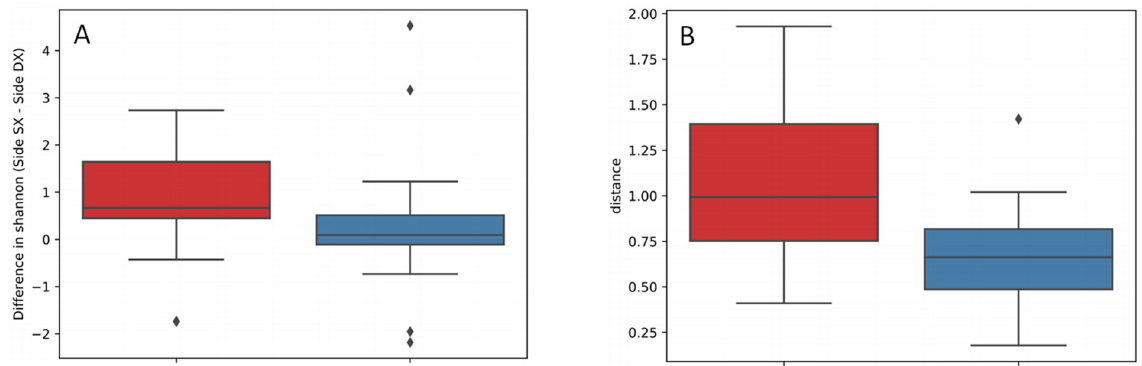
Fig 3. Apha and beta diversity analysis between the two ears from the same animal. Paired differences and distances between right and left ear from the same animal in healthy and otitis affected dogs: (A) Shannon index (P = 0.057); (B) weighted UniFrac matrix (P = 0.021).